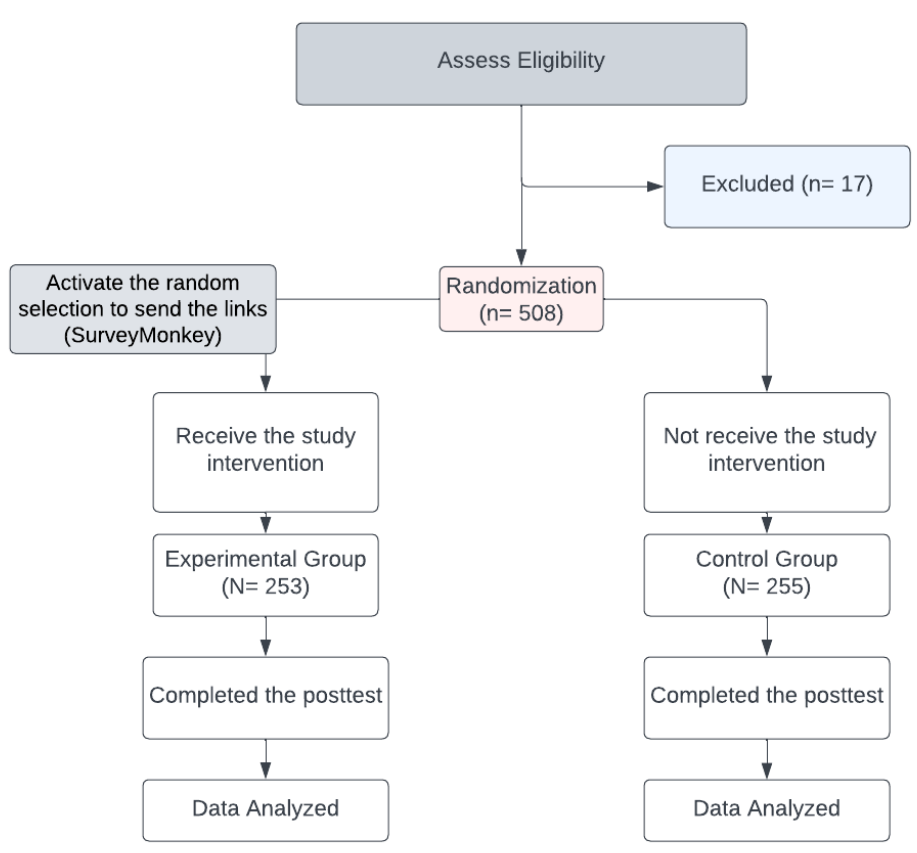
Figure 1. Flow diagram of the allocation of experimental and control groups.